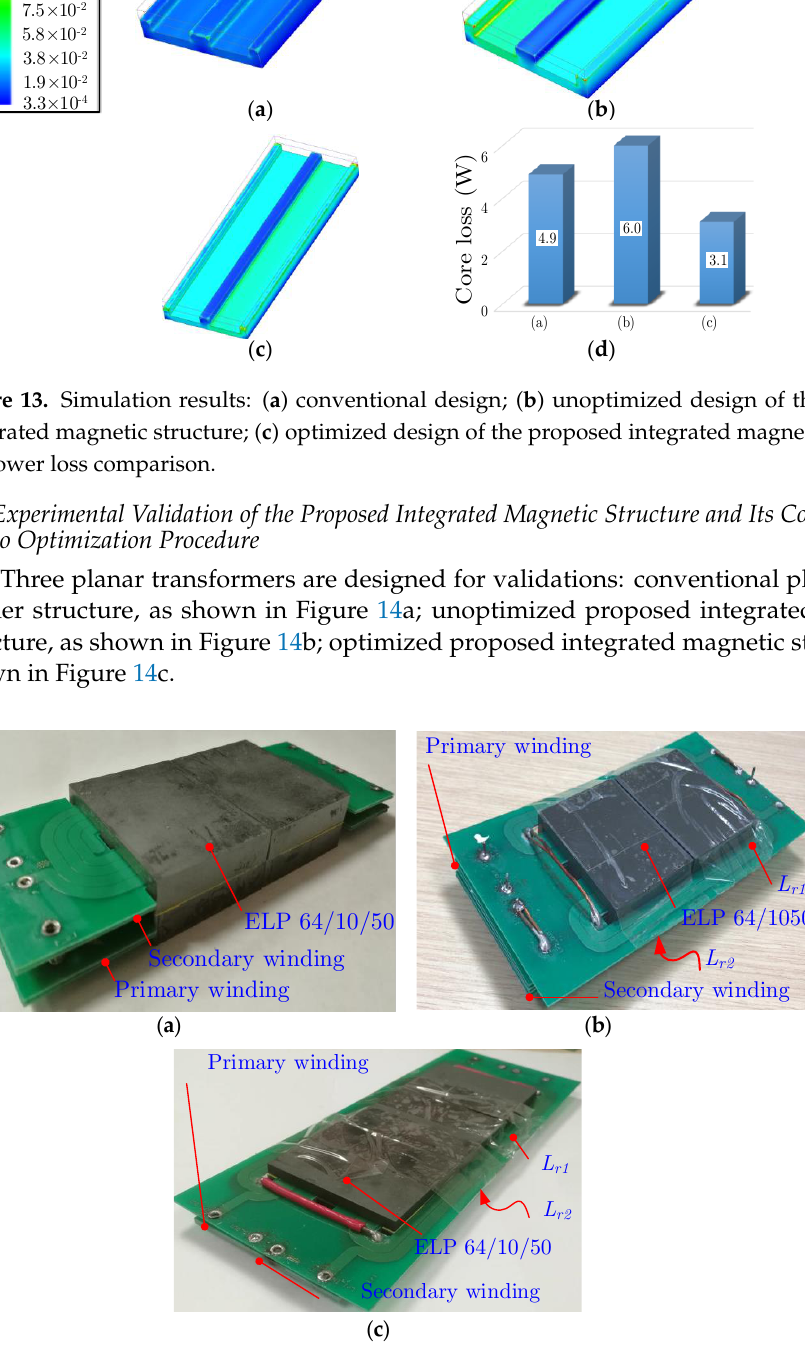
Figure 14. The planar transformers of CLLC resonant converter for validations: ( a ) conventional planar transformer; ( b ) unoptimized proposed integrated magnetic structure; ( c ) optimized proposed integrated magnetic structure.